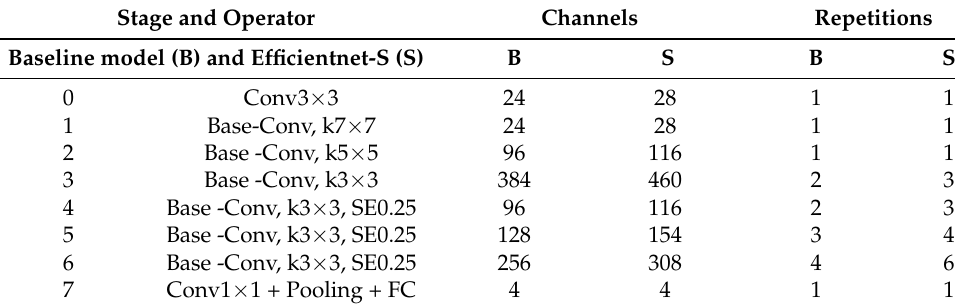
Figure 3. Base convolution block. Table 1. Baseline model and Efficientnet-S structure